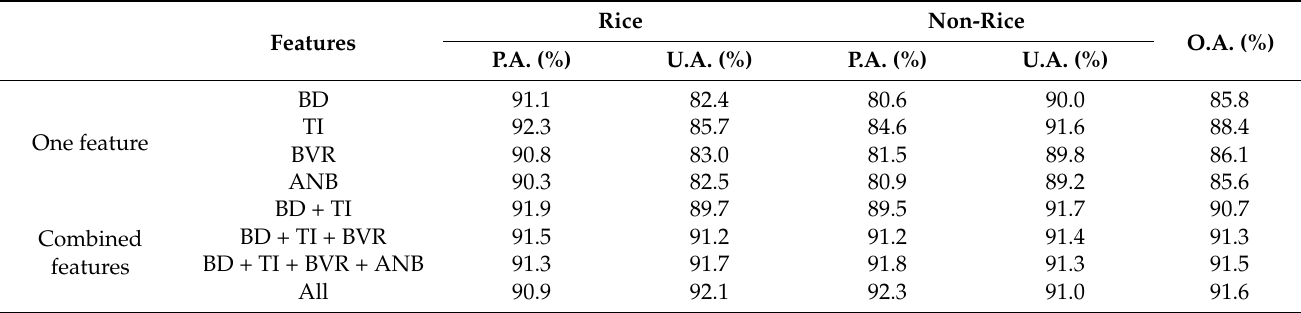
Table 3. Detection accuracy of the proposed features for VH polarization with ascending orbit mode. The P.A., U.A. and O.A. represent the producer accuracy, user accuracy and overall accuracy, respectively.